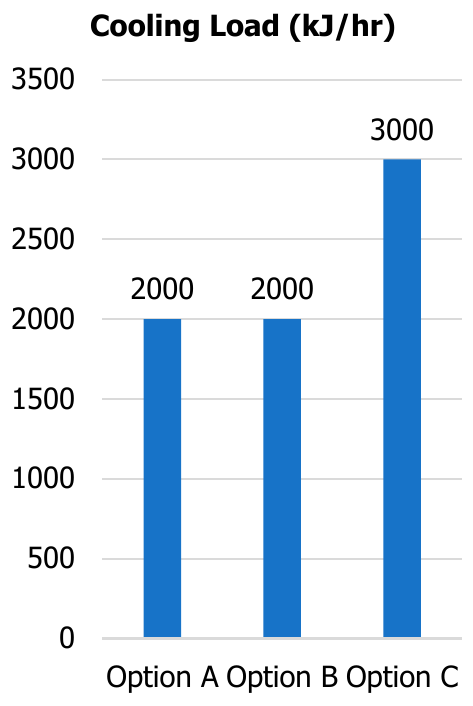
Figure 29. Cooling load comparison.